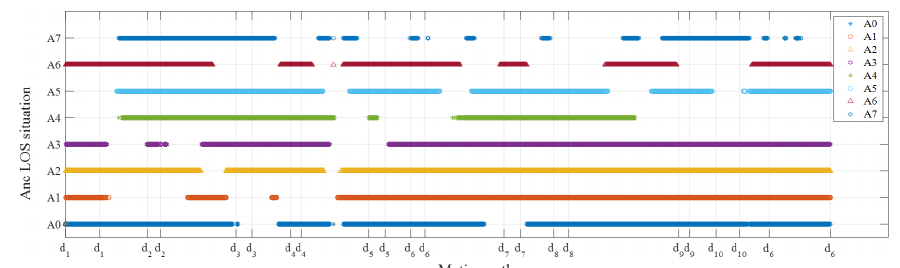
Figure 19. LOS selection of each anchor under the path of Experiment 2.